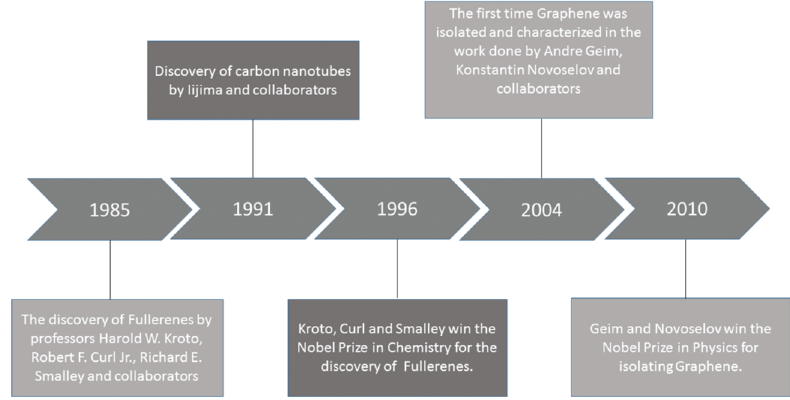
Figure 1: Timeline of carbon